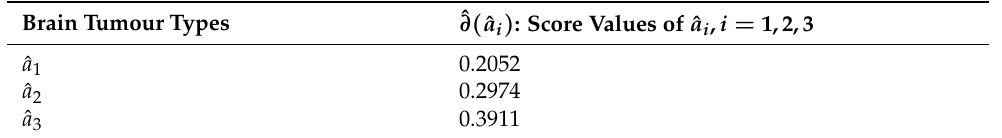
Table 14. Scores of alternatives ˆ a i , i = 1,2,3 corresponding to ˆ ℘ j , j = 1,2,3,4 computed through geometric